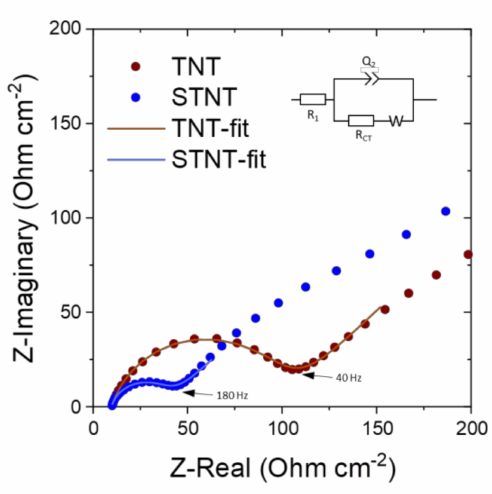
Figure 6. Nyquist Plots of STNT and TNT anodes along with the fits based on an equivalent circuit (shown in the